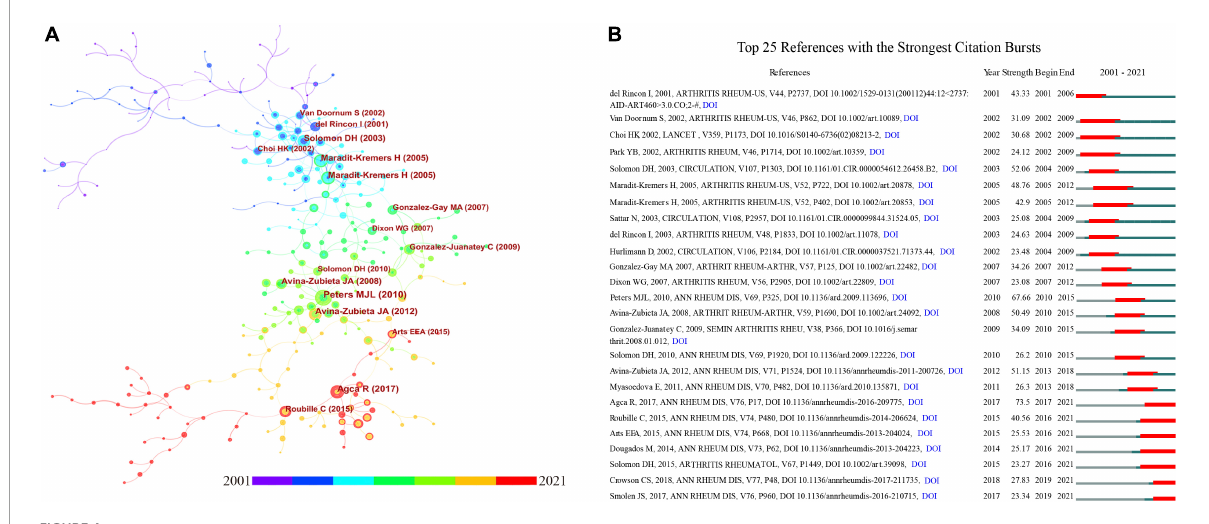
FIGURE4 (A) The co-cited reference knowledge map. (B) The top 25 references with the strongest citation